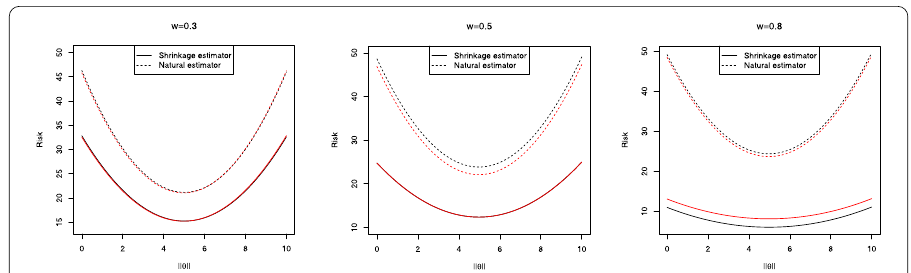
Figure 1 Risk curve for δ (1) 0 ( X ), p = 14, black line for q = 5 and red line for q = 10 for different values of ω